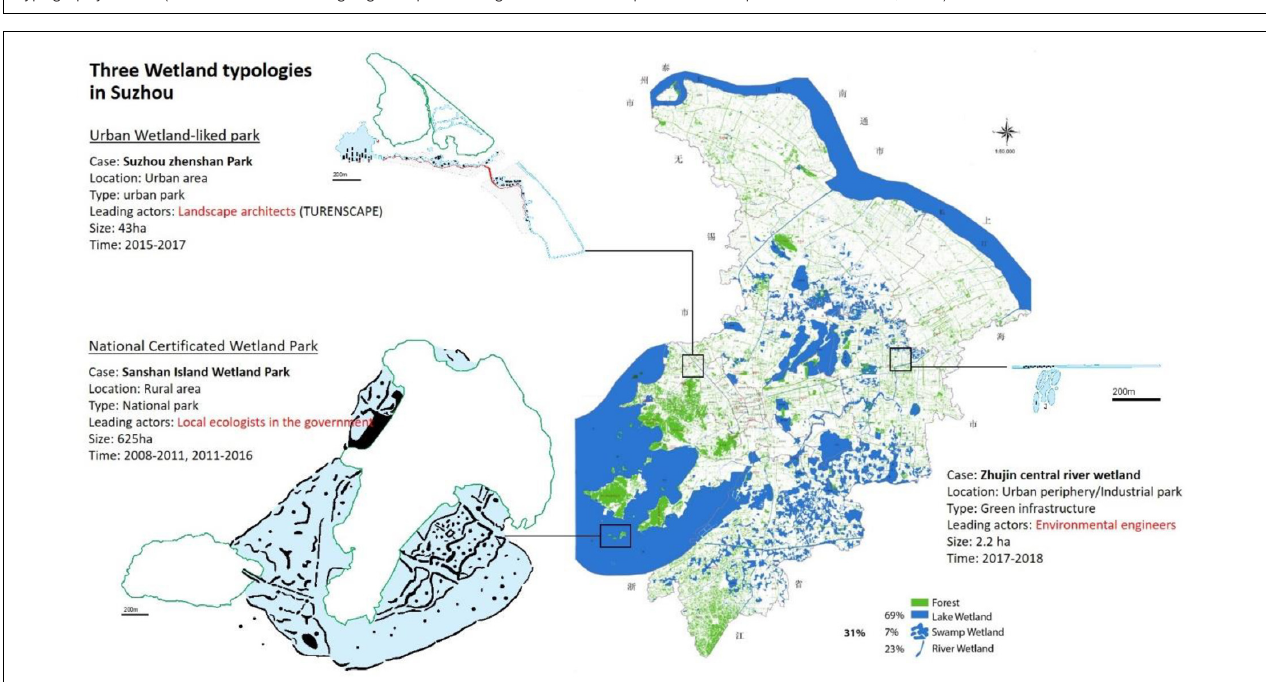
FIGURE 1 | Historical transformations of Tai Lake Basin (TLB). (A) Map of seven prefectures of Southeast China showing the ‘soft edge’ archipelago water morphology and lougang (dike-pond) around Tai Lake (Source: Zhang, 1639). (B) Existing jurisdiction plan and numbers of ‘Wetlands Parks’ on the low-lying typography of TLB (Source: data from the google map searching with a based map that was adapted from Nolf et al., 2020).